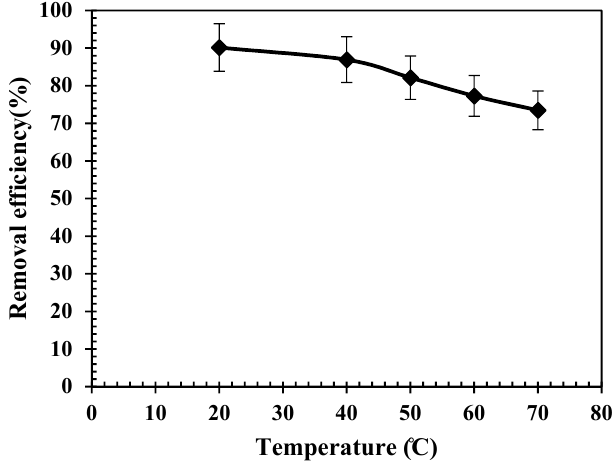
Figure 12. Effect of temperature on arsenic removal efficiency.